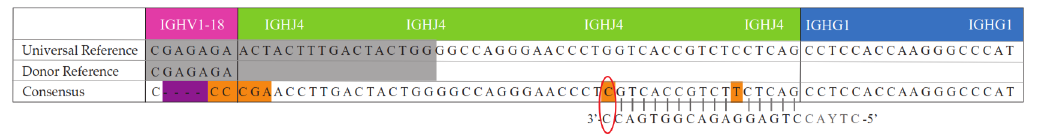
Figure 3. Alignment between the DNA sequence of EuroClonality-NGS protocol’s reverse primers IGH-J-A-1 and IGH-J-A-2 (written in 3 ′ -to-5 ′ direction) and the rearranged sequence of the dominant clonotype (“Consensus”) as displayed by Loupe V(D)J browser for patient sample PLC-14. Nucleotides highlighted in orange in the Consensus sequence represent mutated positions compared with the germline IGHJ4 gene (’Universal Reference”). The gray background indicates where the sequences align to the reference. The purple background corresponds to a nucleotide deletion. The red oval indicates the mutated nucleotide causing a misannealing of input DNA with the 3’ end of both reverse primers used in the first-step PCR, and thus prevents PCR priming. Nucleotides indicated in grey in the primers’ sequence belong to the intron separating the J segment of the rearranged V-region and the C-region sequence. This intron is removed after transcription by RNA splicing joining the V-region exon to the C-region sequence, and for this reason, this portion of the reverse primers does not match with the consensus sequence of mature RNA transcript.